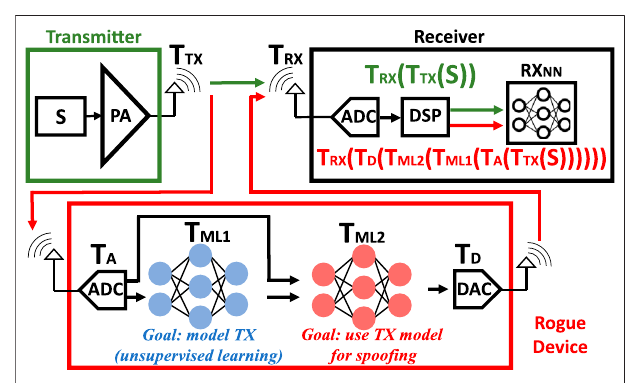
FIGURE10| MLattackmodel.AdversaryMLnetworkscannotundothe effect of ADC and DAC which requires extremely high precision and resolution, making the attack